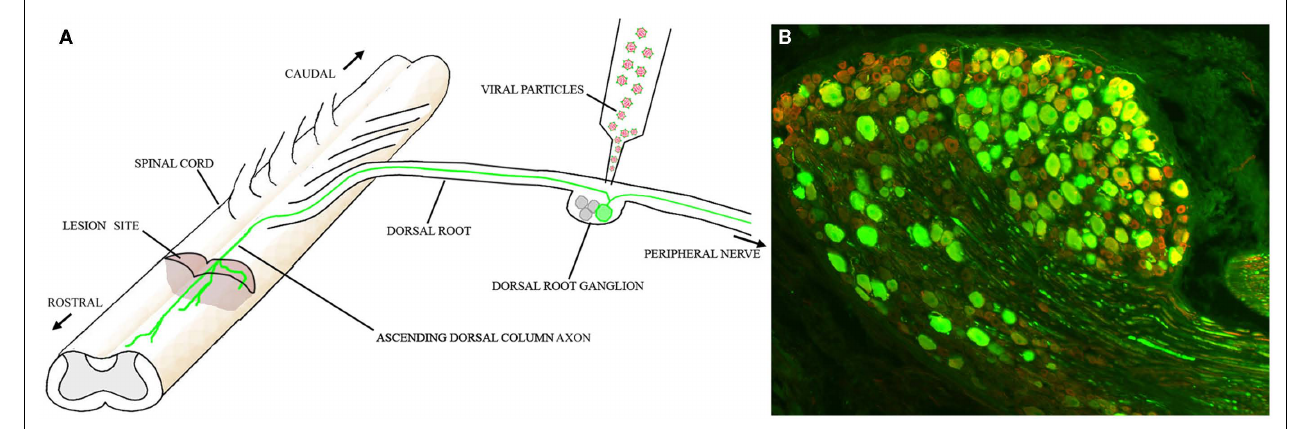
TFs induce RAG expression in the transduced neurons. (B) Expression of GFP in an L5 DRG 12weeks after injection of AAV5-CMV-GFP. Almost the entire neuronal population is transduced. Green: GFP; Red: β III